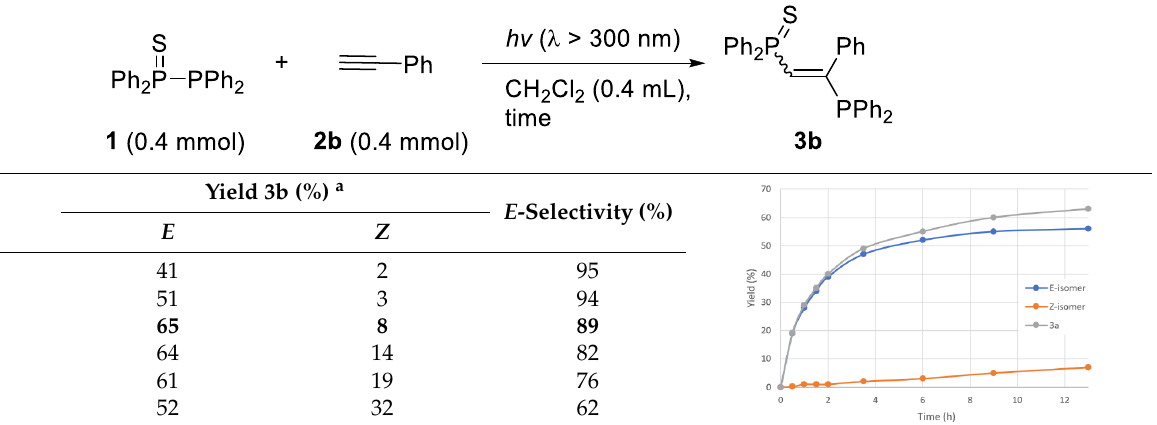
Table 2. Time-dependent profiles of the bisphosphination of phenylacetylene 2b .